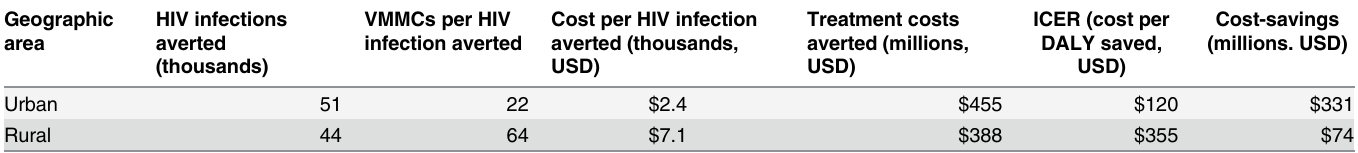
Table 3. Impact and cost of scaling up VMMC coverage to 60% among males ages 10 – 34 in urban and rural Malawi, 2015 – 2029. Geographic